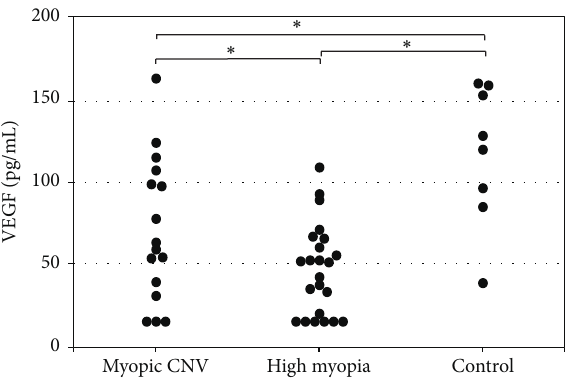
Figure 1: Vascular endothelial growth factor concentrations in the aqueous humor in eyes with myopic choroidal neovascularization (CNV), high myopia without myopic CNV, and controls. ∗ 𝑃 < 0.05 .